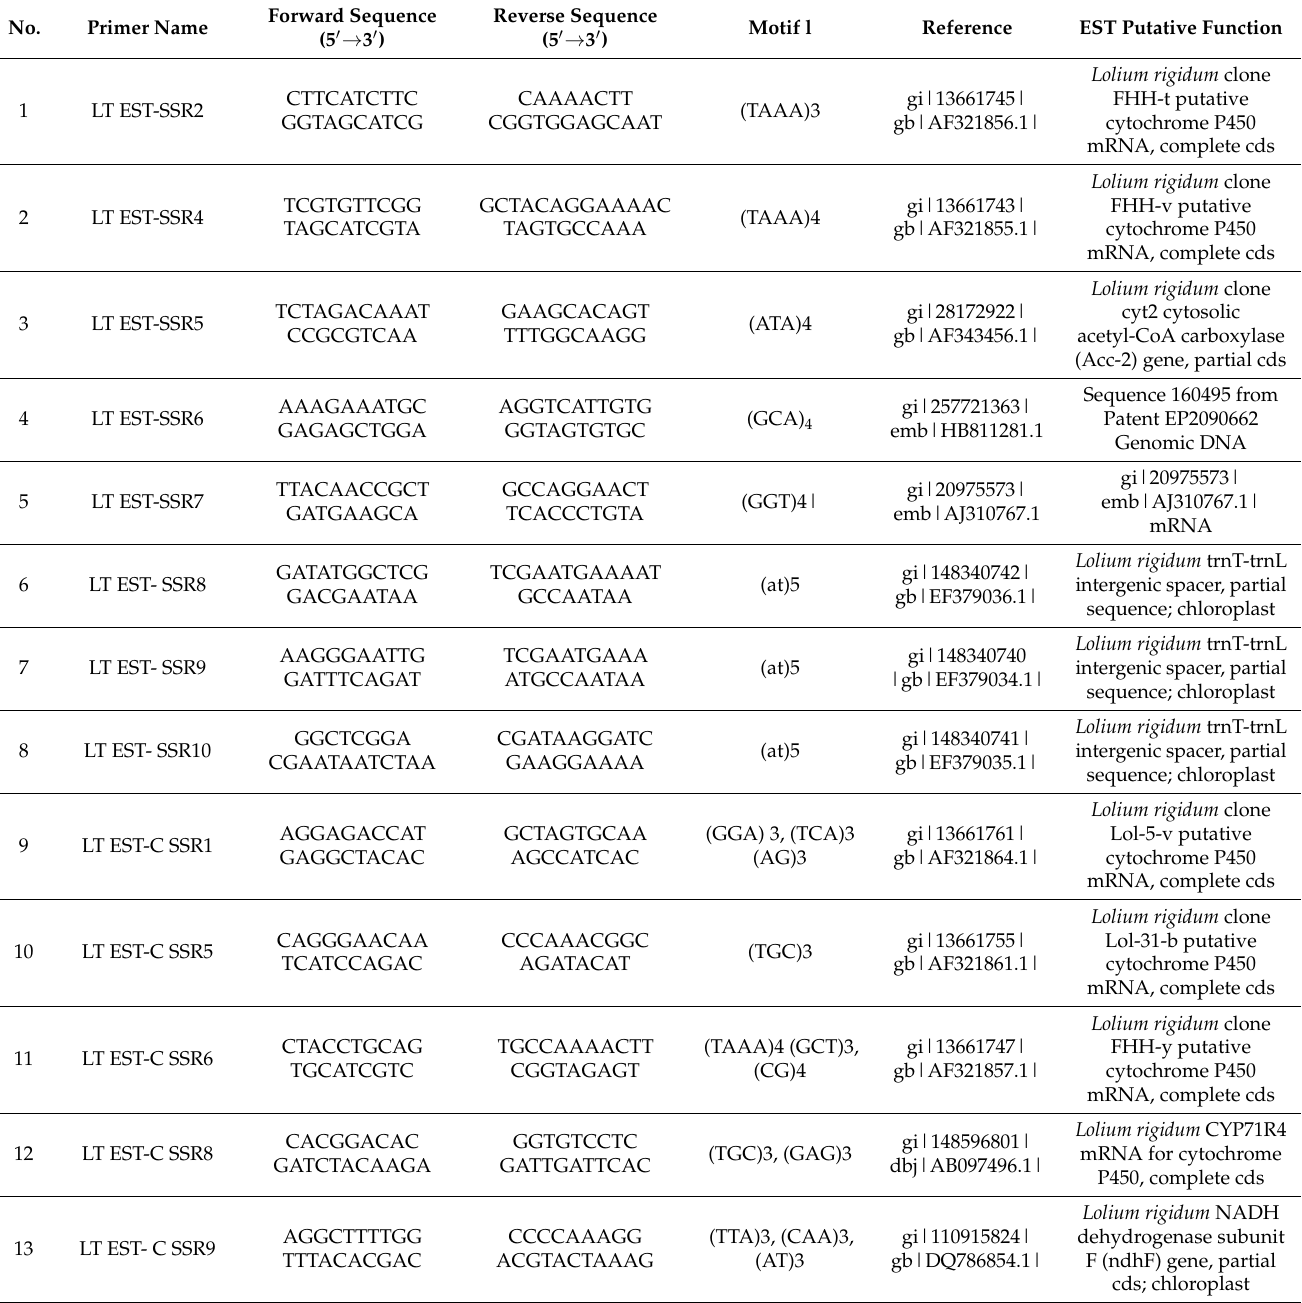
Table 2. List of SSR primers used and their basic